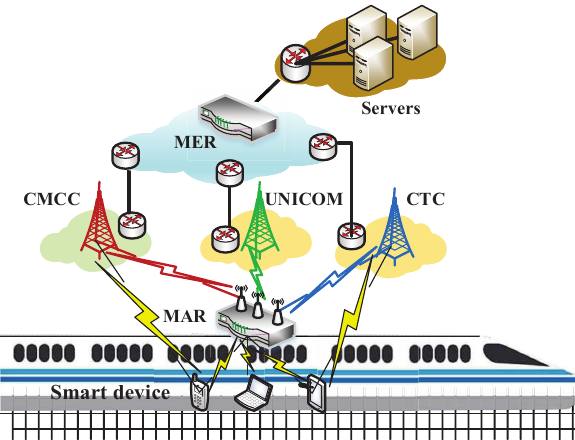
Figure 2. Vehicle-to-cloud multipath transmission network topology.